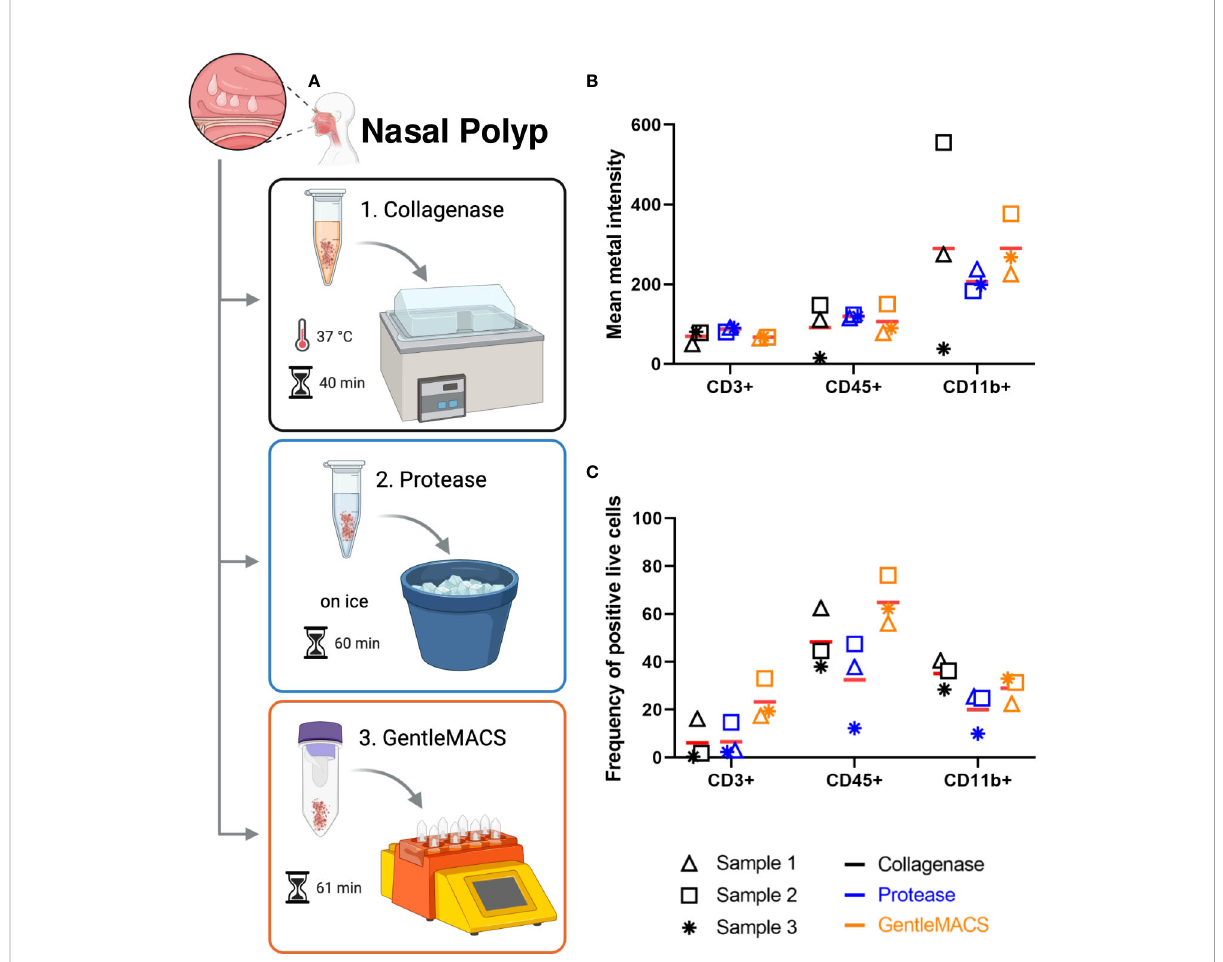
FIGURE 1 Nasal polyp digestion protocols for mass cytometry. (A) Nasal polyps were minced, and submitted to one of the following digestion protocols: 1. incubation at 37°C in a water bath for 40 min in collagenase solution; 2. incubation on ice for 60 min in protease solution; and 3. incubation for 53 min in enzyme mix (A, D, and R enzymes) in GentleMACS ® (Miltenyi). Single cell suspensions obtained were used for labeling according to the Maxpar Direct Immune Pro fi ling Assay (MDIPA) protocol ( fi gure created with BioRender.com). (B) Mean metal intensity (MMI) of CD3, CD45 and CD11b positive live cells obtained with each protocol by mass cytometry. Bars represent mean of three independent experiments. (C) Percentage of CD3, CD45 and CD11b positive live cells obtained with each protocol by mass cytometry. Lines represent mean of three independent